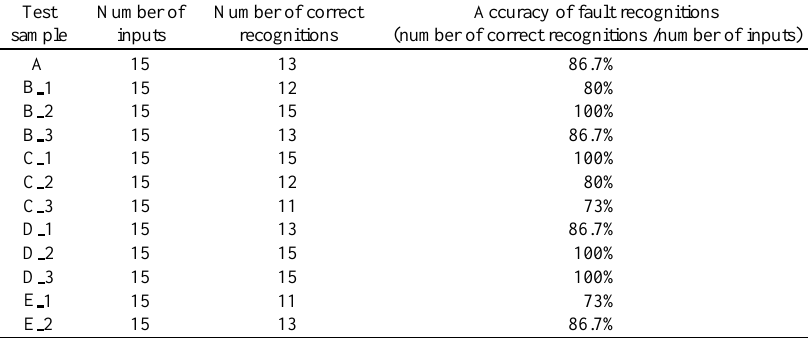
Table 3 Accuracy of fault